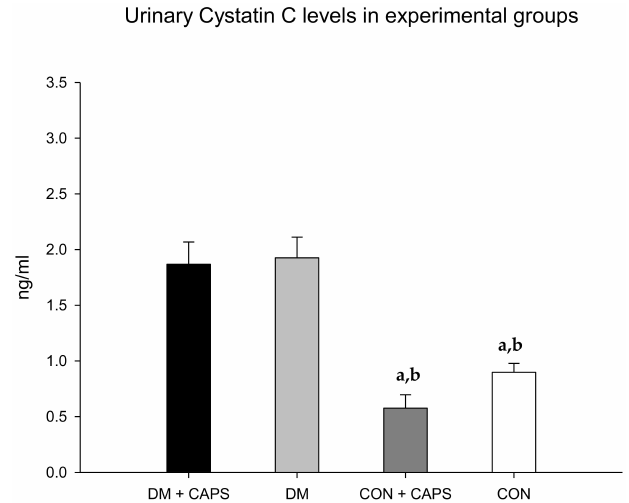
Figure 3. Effect of 8 weeks of capsaicin administration (1 mg/kg/day) on urinary cystatin C levels. ( a ) Statistically significant difference in comparison with the DM group + CAPS; ( b ) statistically significant difference in comparison with the DM group. Data are 3 mean ±